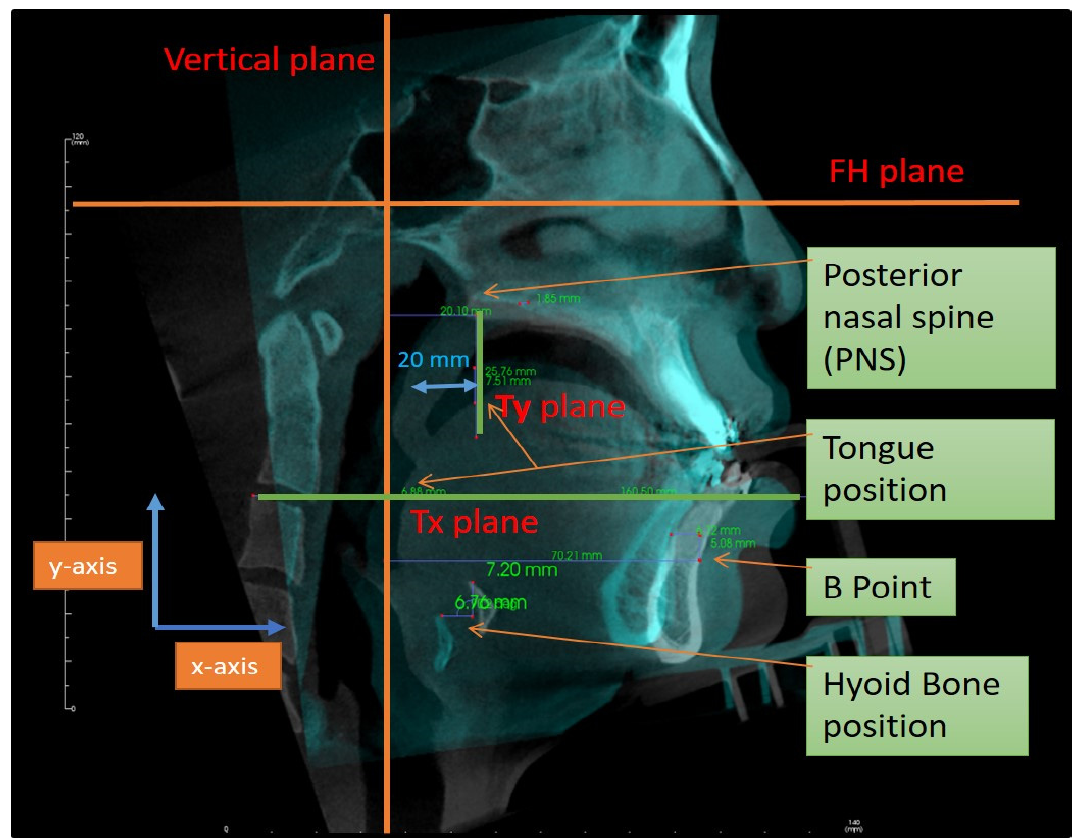
Figure 1. Skeletal measurements using superimposition of the pre- and post-cone-beam computed tomography (CBCT). Processes 2020 , 8 , x FOR PEER REVIEW